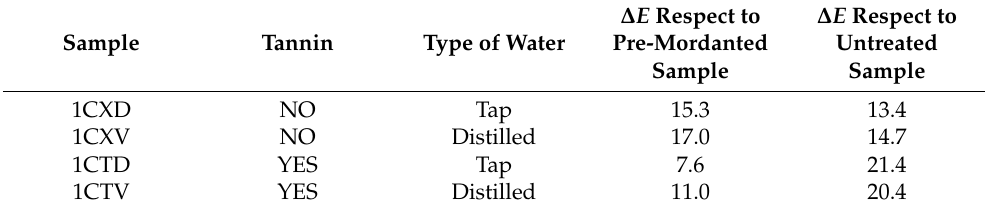
Table 7. Colorimetric values obtained for the pre-mordanted samples dyed with calendula.